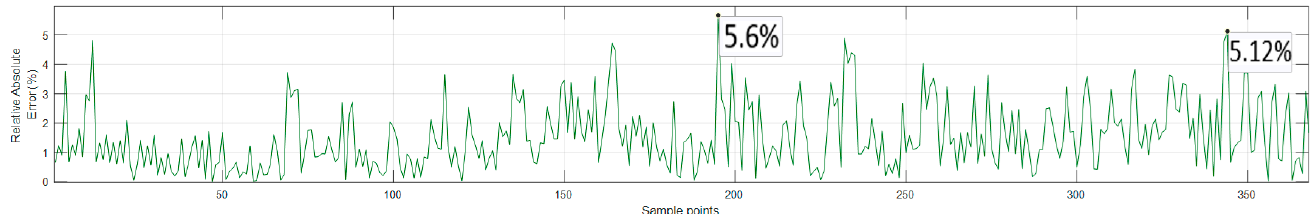
Figure 9. P c N Actual vs. P c N Estimated : Relative Absolute Error over 368 data samples.